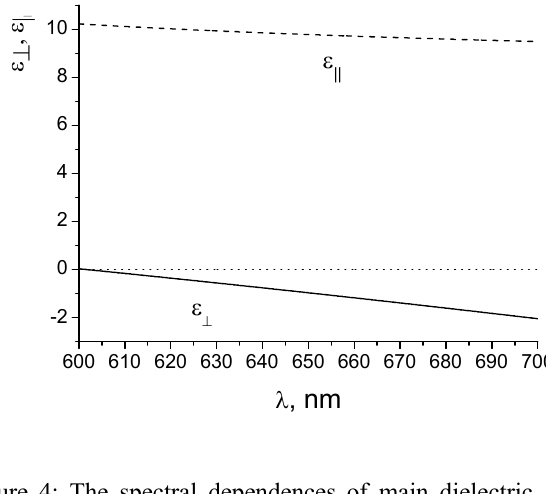
Figure 4: The spectral dependences of main dielectric permittivities of the II type HMM on the basis of multilayered Ti O /Ag nanostructure. 3 5